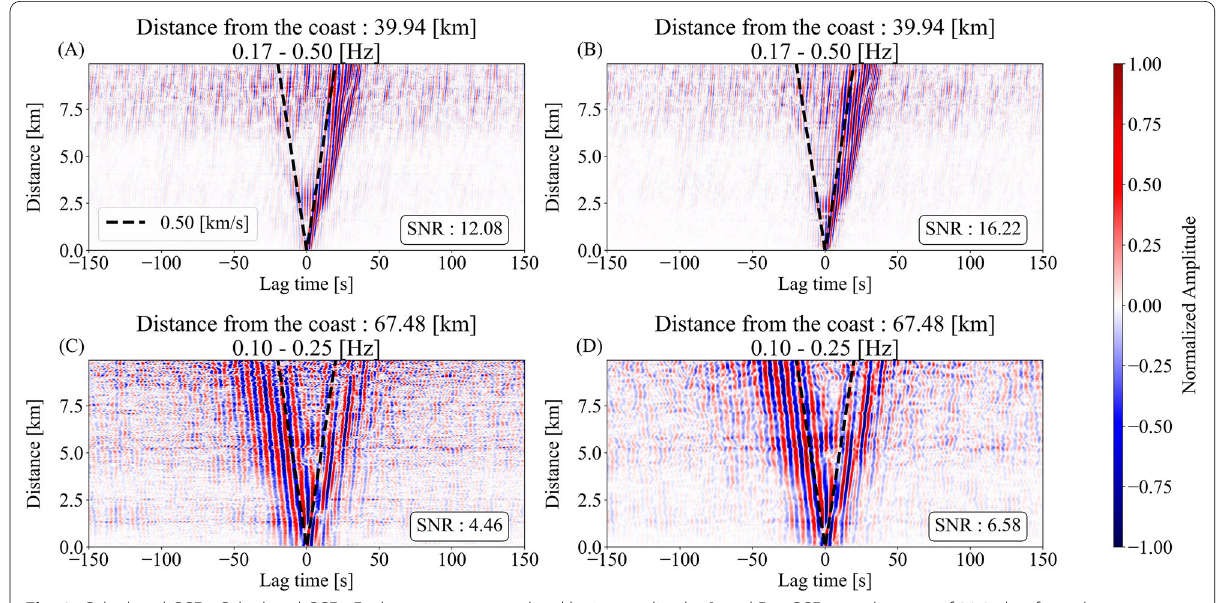
Fig. 2 Calculated CCFs. Calculated CCFs. Each trace was normalized by its amplitude. A and B —CCFs at a distance of 39.94 km from the coast without and with an FK filter, respectively. The frequency range was between 0.17 and 0.50 Hz. C and D —CCFs without and with an FK filter at 67.48 km from the coast in the frequency range between 0.10 and 0.25 Hz. SNR indicates the signal-to-noise ratios calculated by Bensen’s (2007) method. The dashed lines indicate an apparent velocity of 0.5 km/s. The FK filter improves the SNR values and enables effective extraction of surface